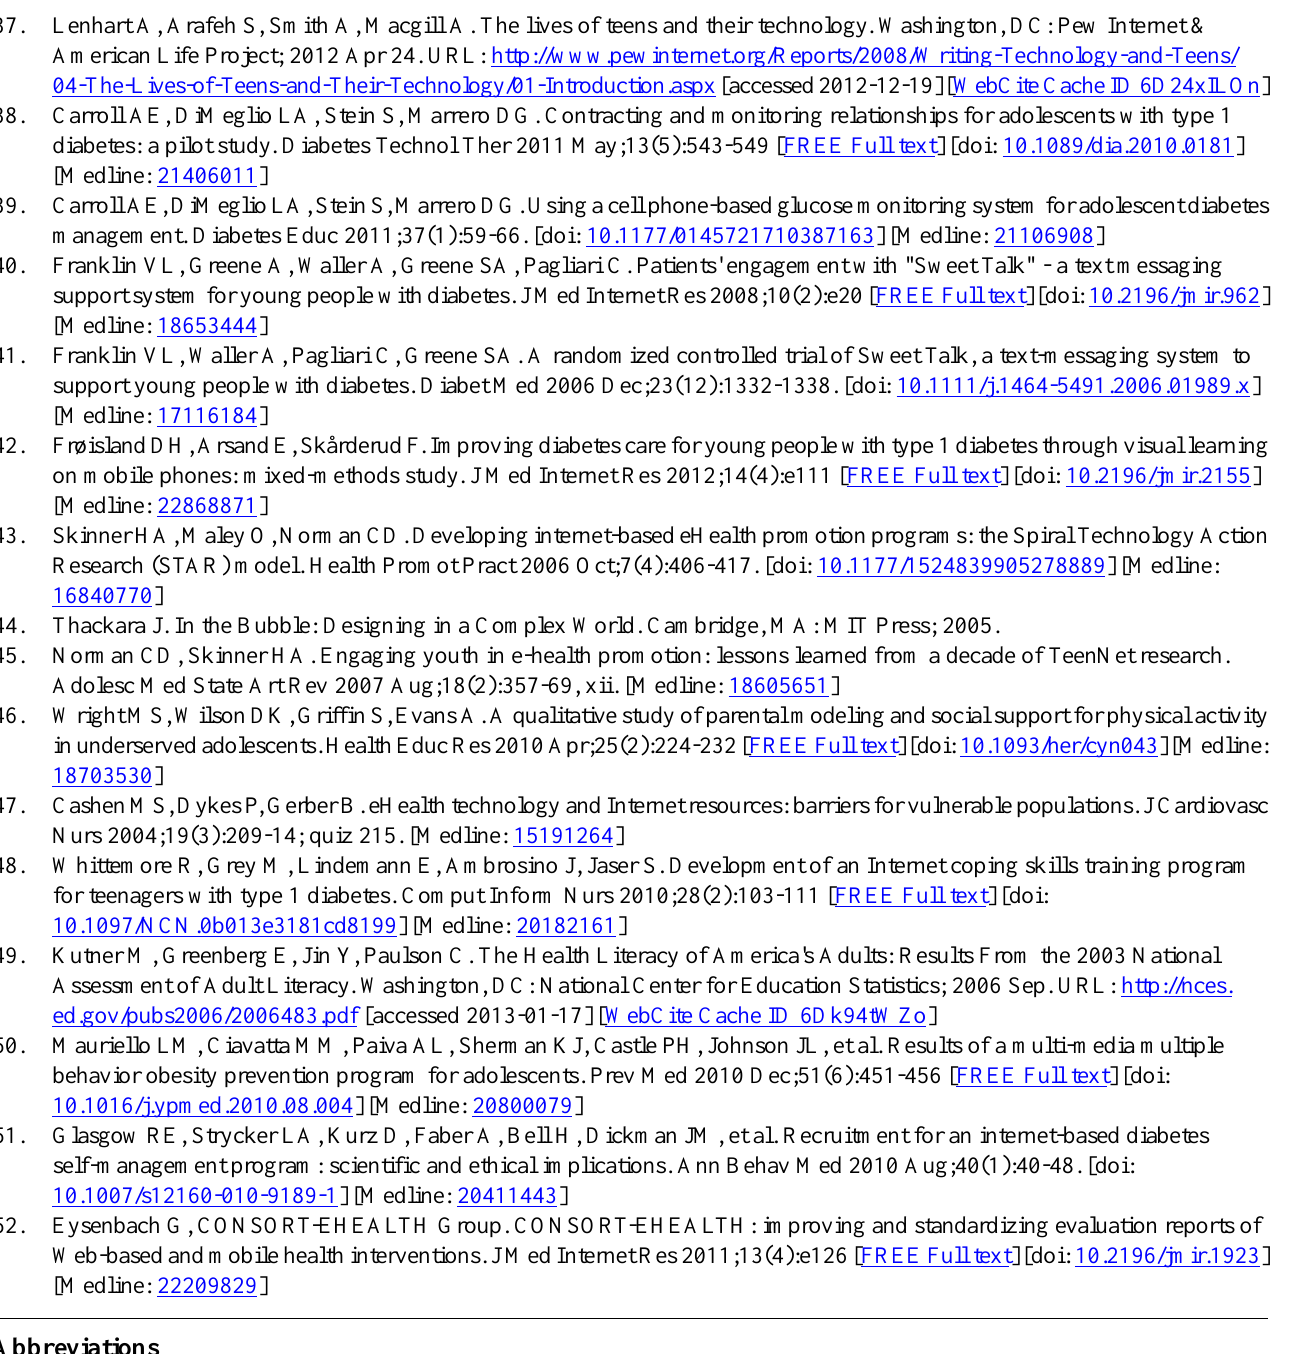
Abbreviations A1C: glycosylated hemoglobin ADA: American Diabetes Association CDI: Children’s Depression